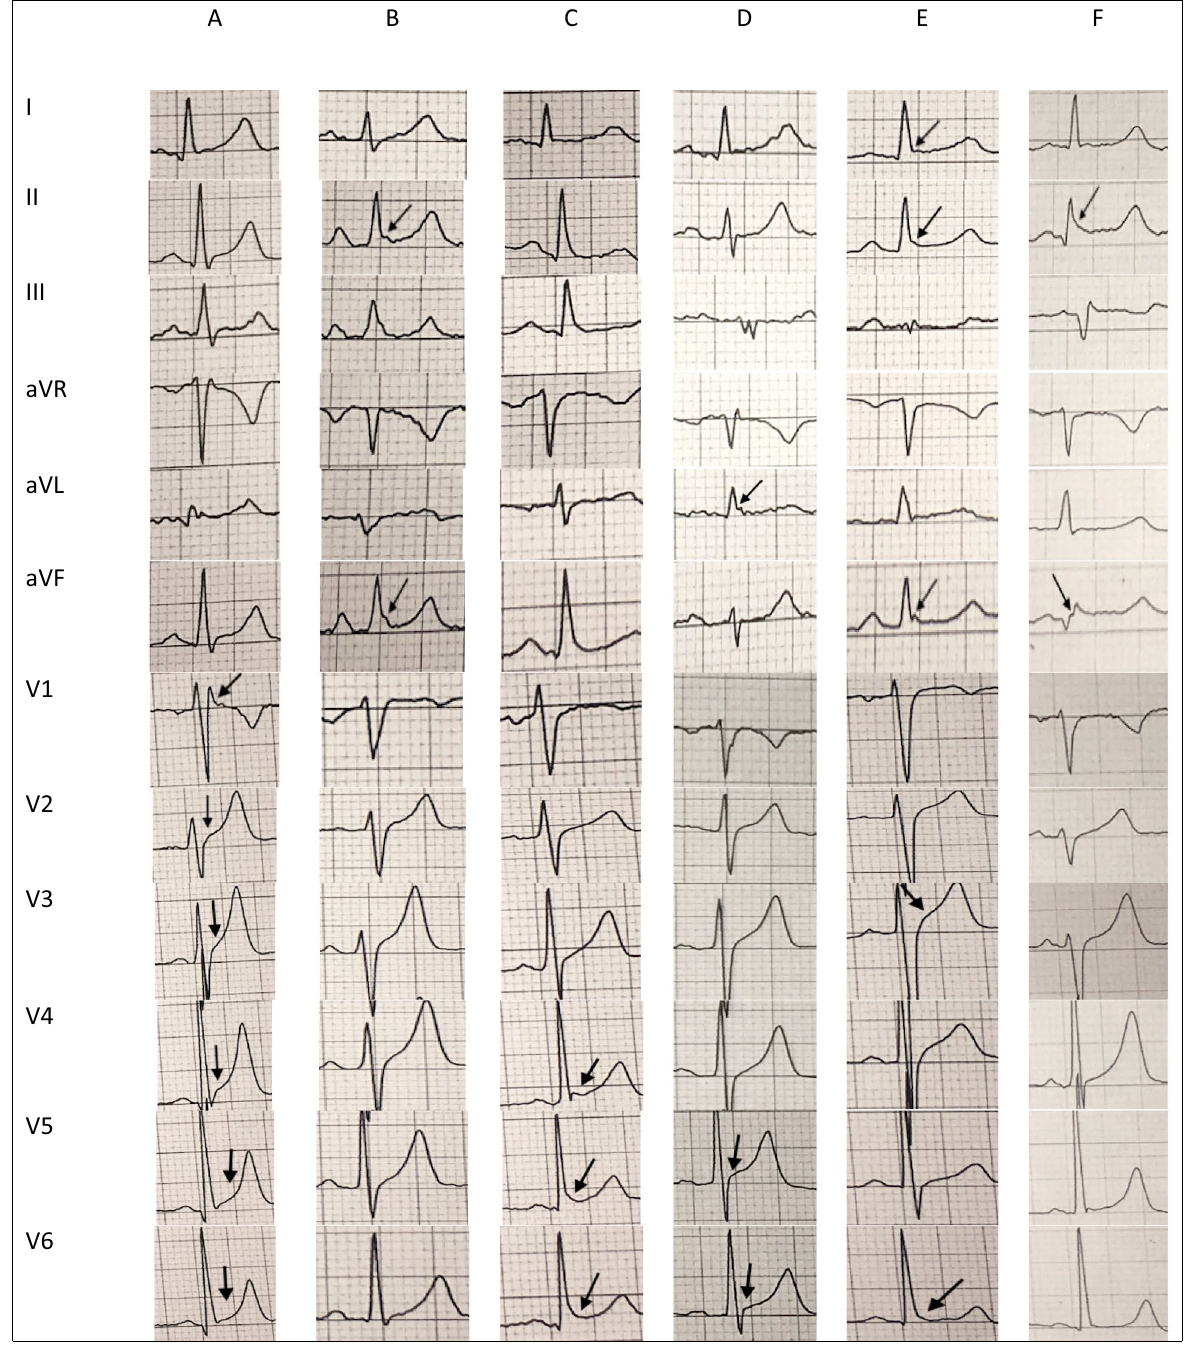
Figure 3. Baseline ECG characteristics of persons with short QT interval and early repolarization. ( A ) [case #8] a 47 Y/O male with a score 2 QTc, bradycardia (HR: 47), incomplete RBBB (rsr´ pattern in lead V1) and generalized ER; ( B ) [case #12] a 56 Y/O male with a score 1 QTc, a history of SCD in his niece and inferior leads ER; ( C ) [case #28] a 46 Y/O male with a score 1 QTc, bradycardia (HR: 51) and lateral leads ER; ( D ) [case #57] a 49 Y/O male with a score 1 QTc, low voltage ECG and lateral leads ER; ( E ) [case #65] a 53 Y/O male with a score 1 QTc, bradycardia (HR: 44) and inferolateral ER; ( F ) [case #67] a 64 Y/O male with a score 1 QTc, bradycardia (HR: 42), low voltage ECG and inferior lead